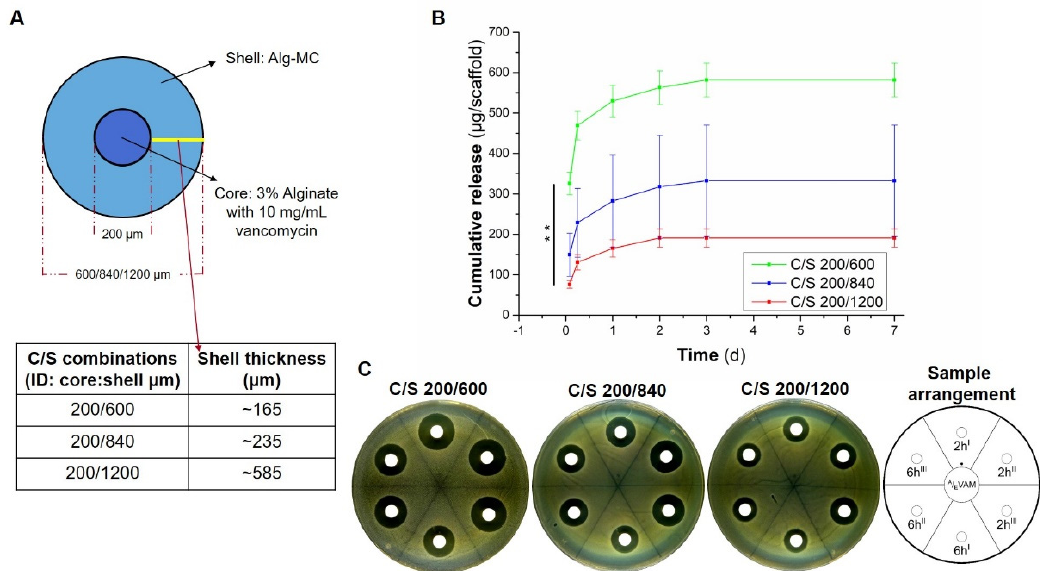
Figure 7. Release of vancomycin from C/S scaffolds: impact of shell thickness. Schematic diagram showing different coaxial needle combinations ( A ). Release of vancomycin from ALG-MC scaffolds having different shell thickness ( n = 5; ** p < 0.005) ( B ). Statistical analysis performed only on burst release, i.e., release of antibiotics at 2 h ( n = 3; ** p < 0.005). Representative images of ZOI formed in the presence of release solutions collected from scaffolds with different shell thickness after 2 h and 6 h, respectively ( C; release solutions obtained from three scaffolds at respective time point were loaded on the sample carrier, denoted by I, II,